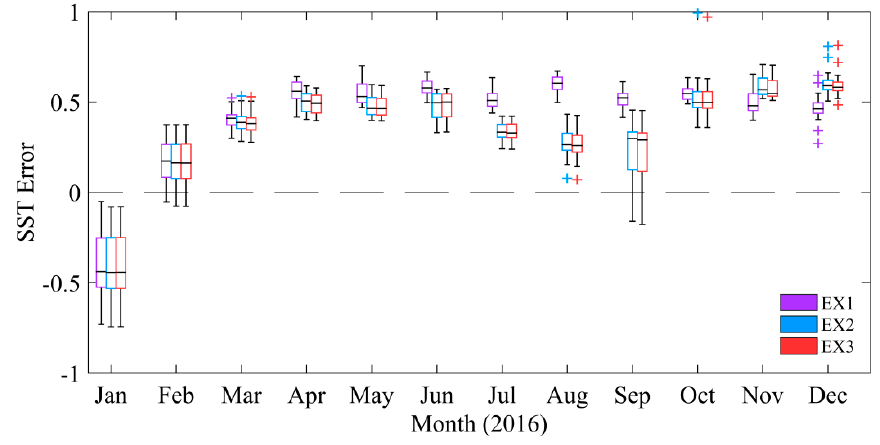
Figure 3. Box and whisker plots of the SST differences between MW_IR and three experiment